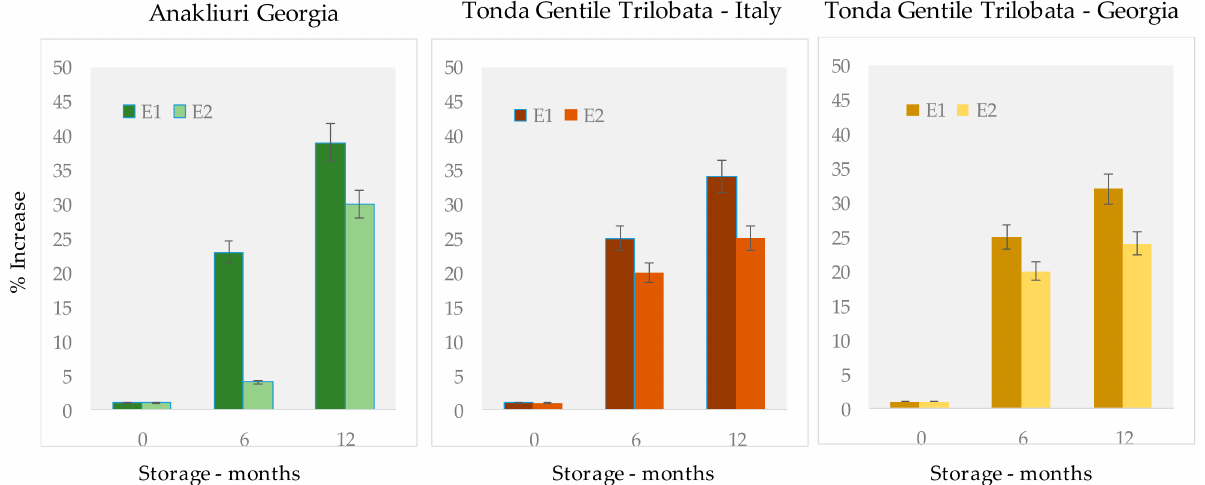
Figure 2. Evolution of total FFA concentration expressed as the percentage increase in oleic acid equivalents (q/100 g) divided/normalized over T0 for Anakliuri and Tonda Gentile Trilobata samples. Dark-color bars correspond to sun drying (E1) and light-color bars correspond to low-temperature drying